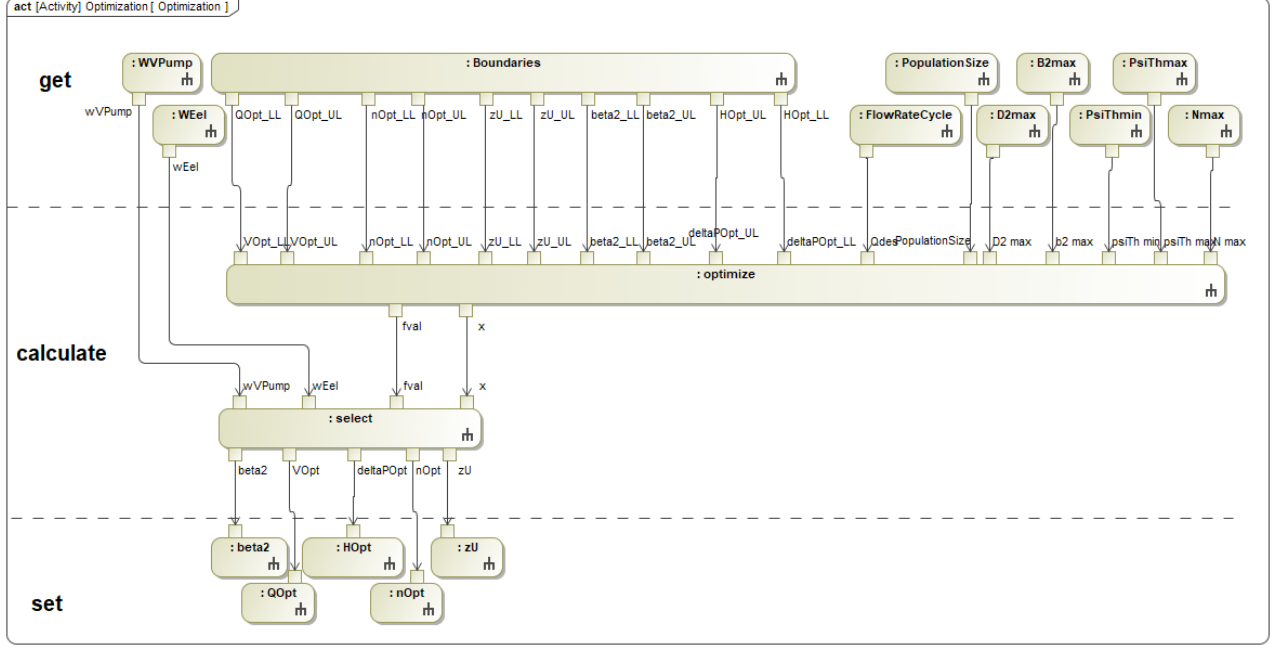
Figure 14. Executable optimization workflow.